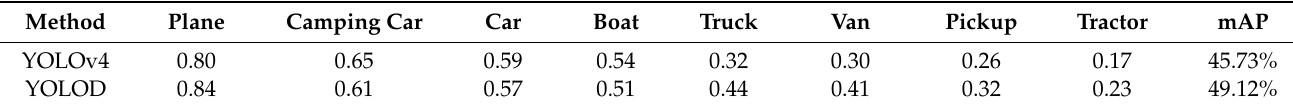
Table 7. Results of training on the VEDAI dataset.